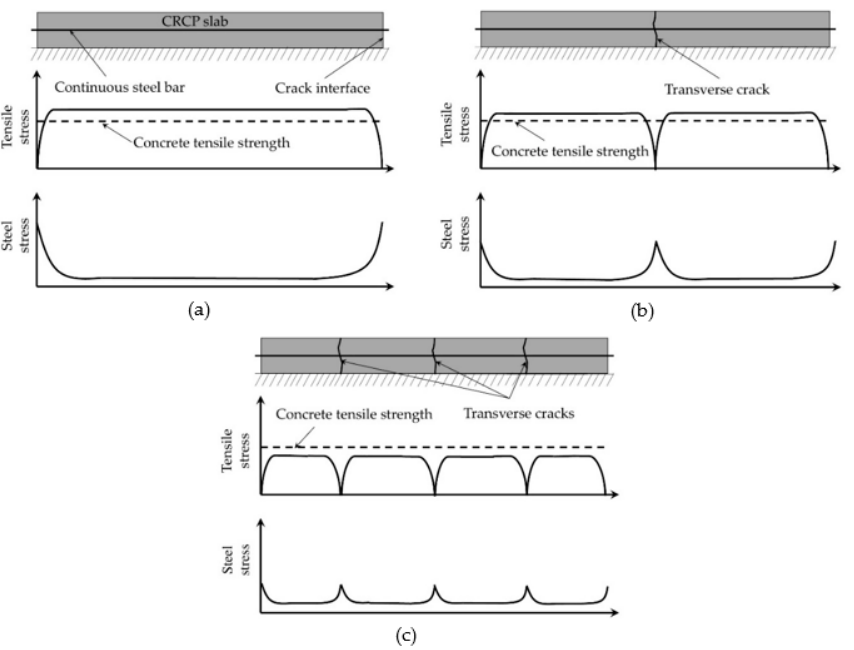
Figure 1. Cracking development in continuously reinforced concrete pavement (CRCP): ( a ) crack initiation; ( b ) crack propagation; and ( c ) fully developed crack pattern.